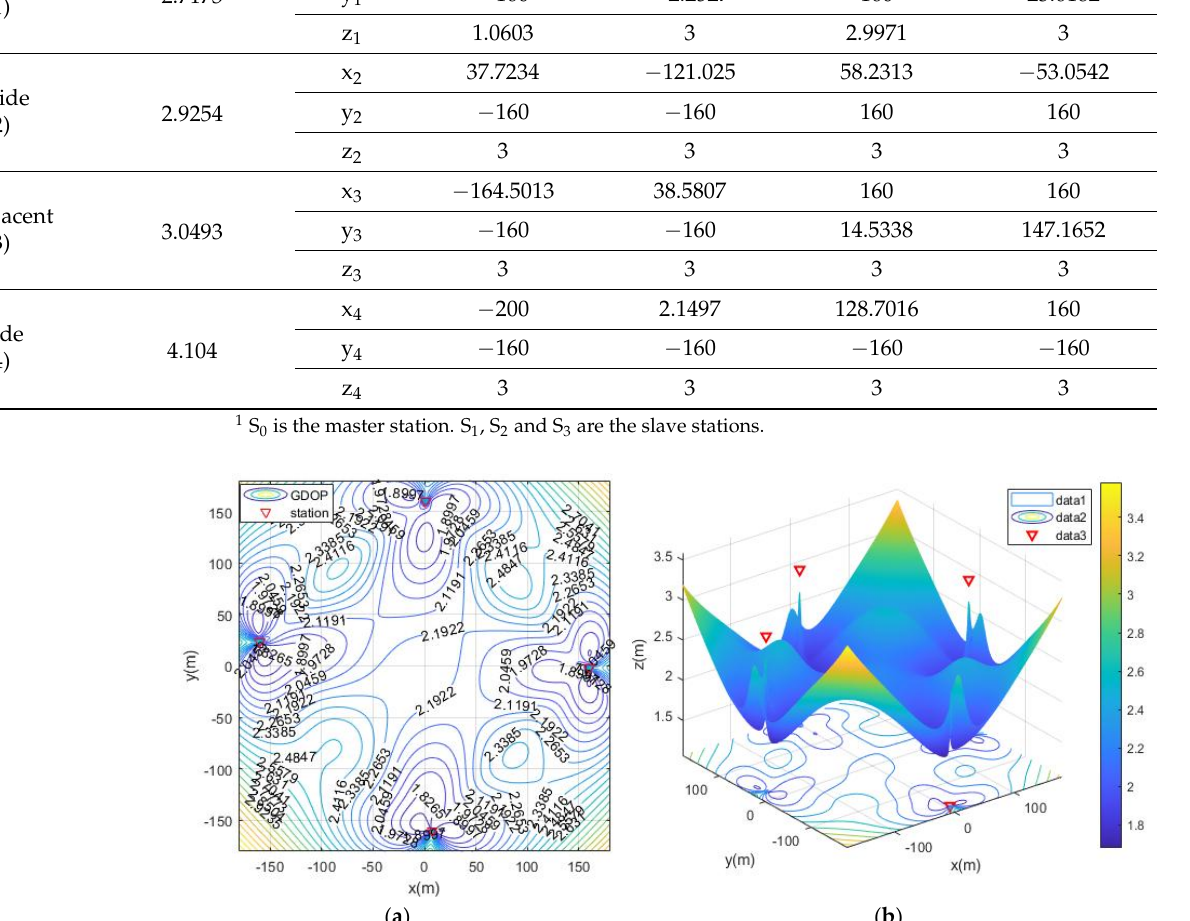
Table 2. Optimized results of the four stations deployments under scenario 2. 1 Deployment